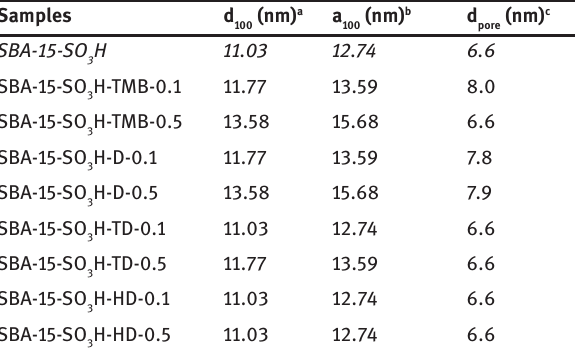
Figure 3: N -sorption isotherm and pore size distribution (inset) of SBA-15-SO -sorption isotherm and pore size distribution (inset) of SBA-15-SO 2 2 Table 1: The structural properties calculated by XRD and N results.